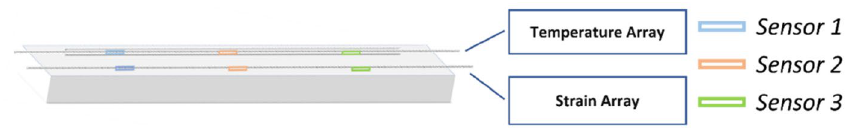
Figure 18. Schematic illustration of surface-bonded FBG arrays measuring in-situ temperature and strain.